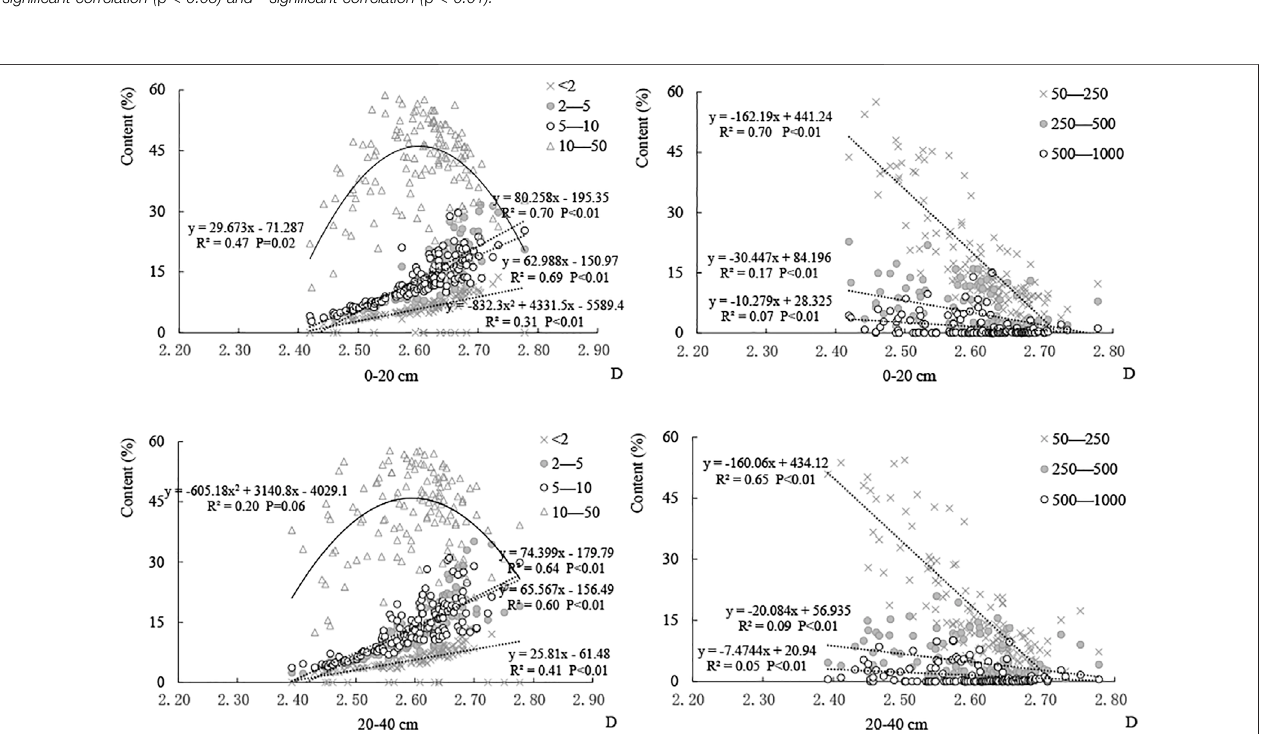
Frontiers in Environmental Science |